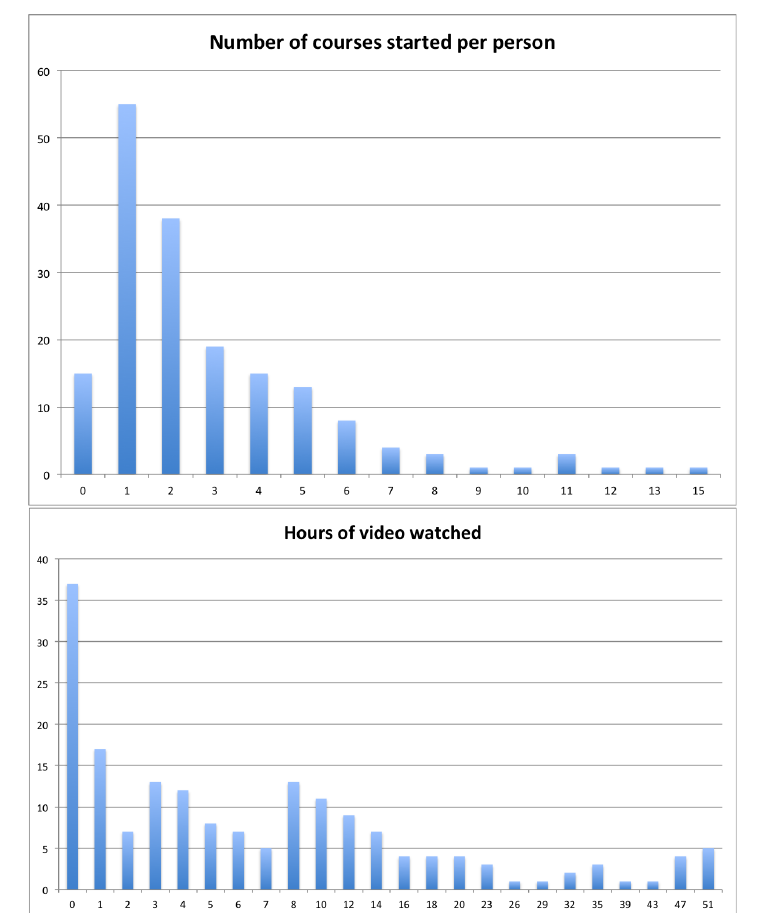
Figure 1. User activity on Udemy for CERN measured as number of courses that have been started per person (top) and cumulated number of hours of video watched per person (bottom). On average, a learner at CERN started three courses and watched ten hours of